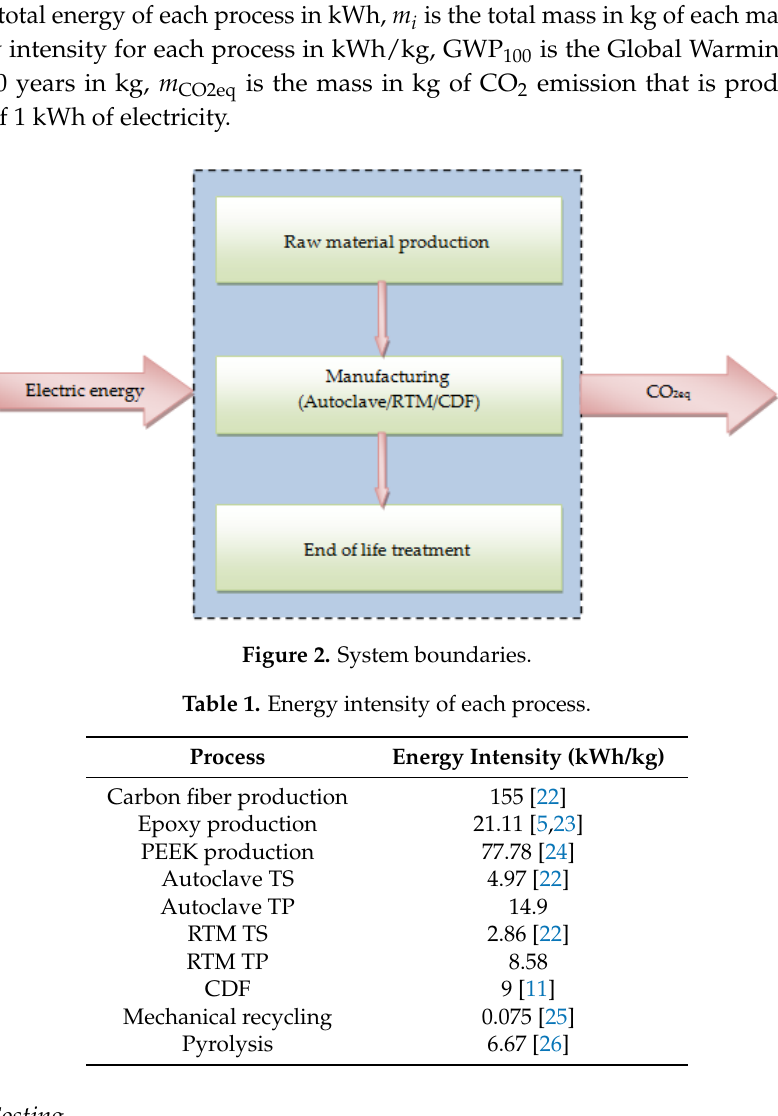
Table 1. Energy intensity of each process.